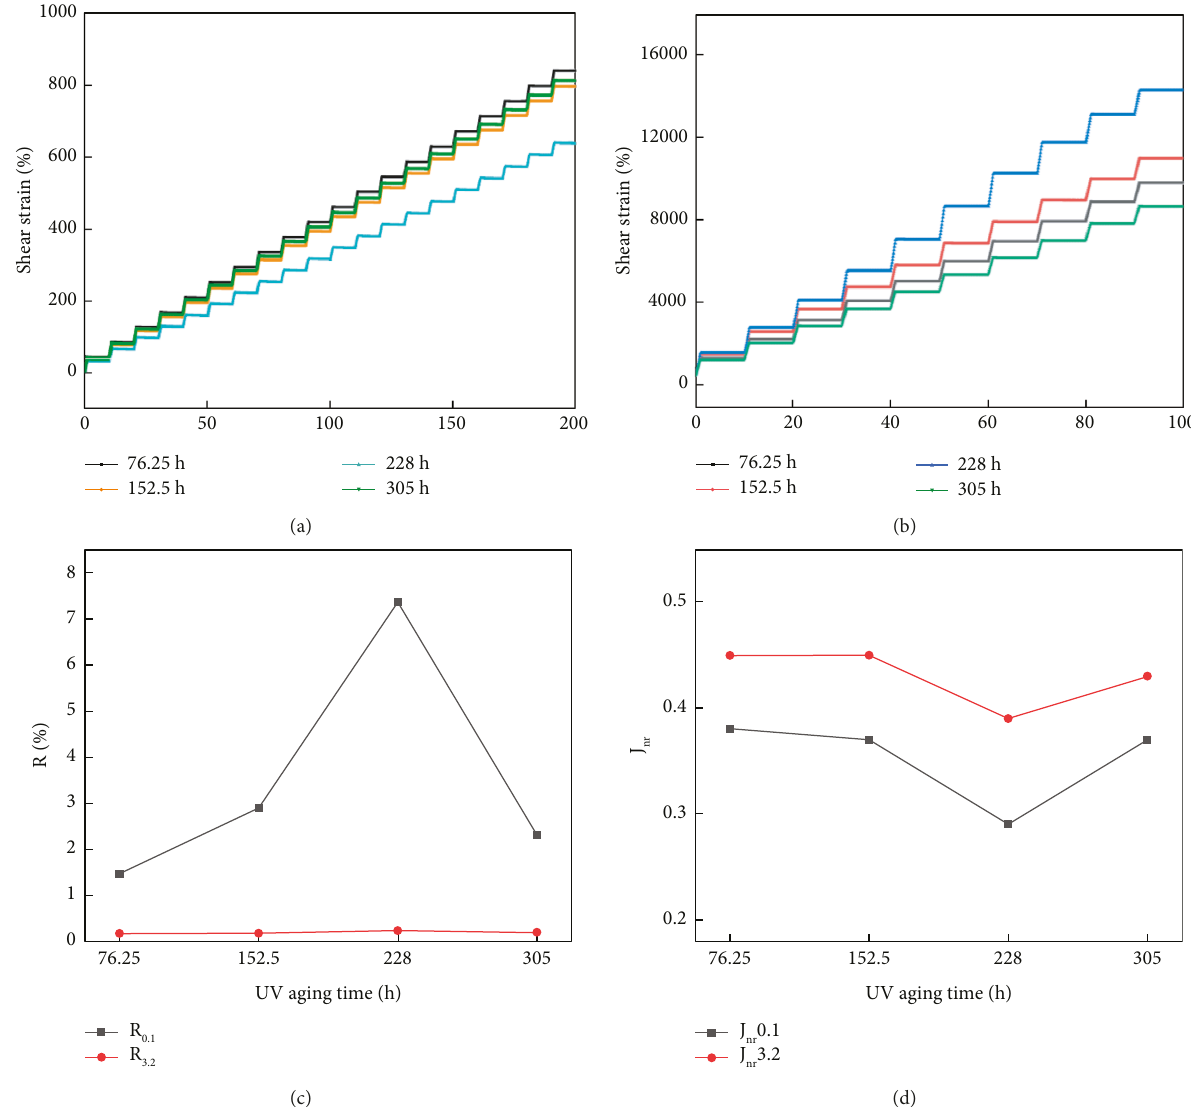
Figure 5: MSCR testing results of 70# base asphalt subjected to UV radiation of different times. (a) 0.1kPa. (b) 3.2 kPa. (c) R value. (d) Jnr